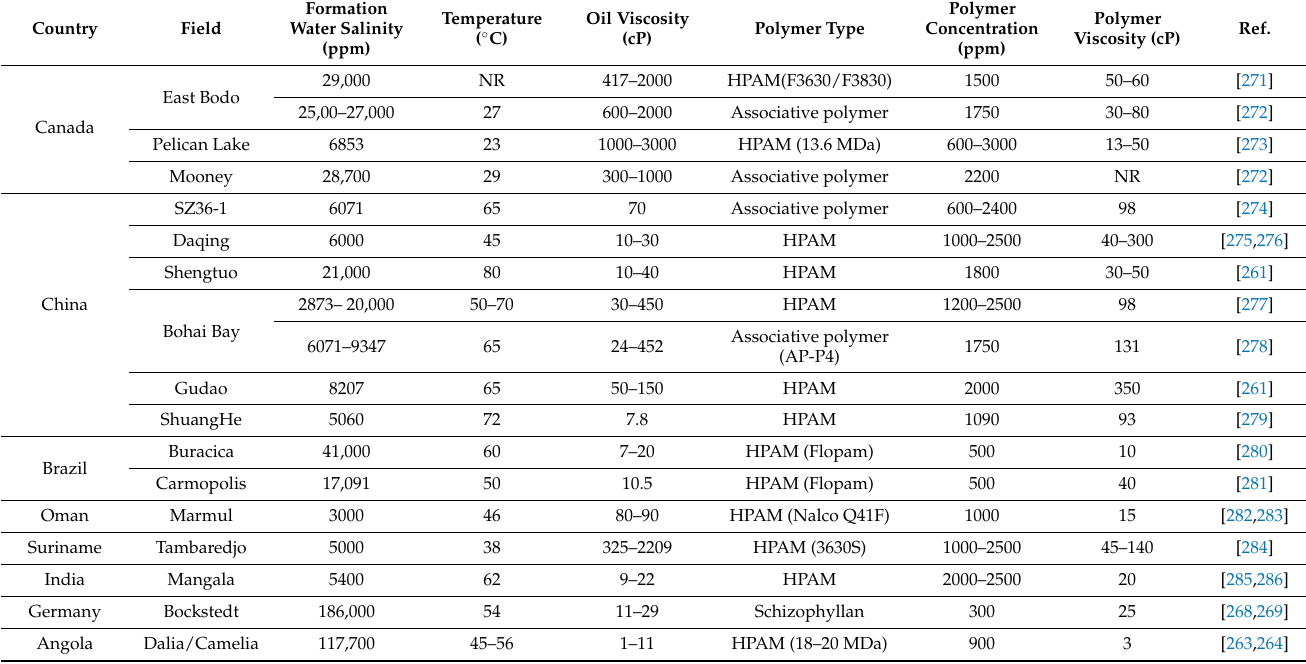
Table 3. Range of parameters in recent polymer flooding field applications (1 MDa = 10 6 g/mol, NR = not